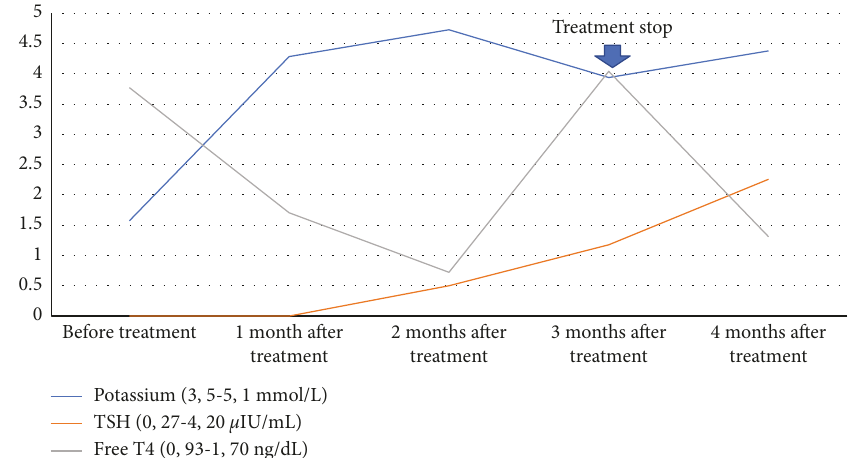
Figure 1: The changes of potassium, TSH, and free T4 before and after therapy of potassium replacement and thyroid